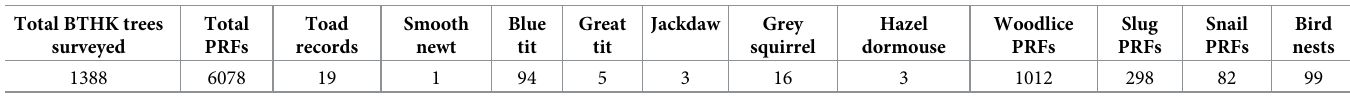
Table 1. Total trees and tree cavities (PRFs) surveyed as part of the standardised monitoring in the Bat Tree Habitat Key scheme in the UK and comparisons of amphibian records with other animal species and bird nests identified. Total BTHK trees